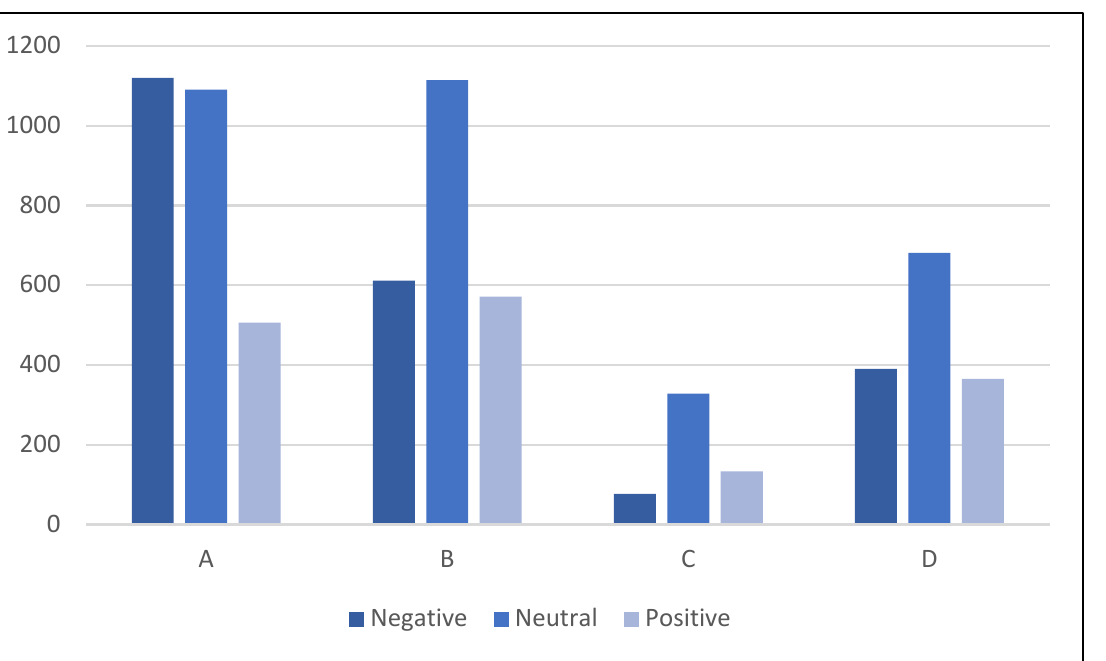
The complete body of work was tokenized, filtered with stop words eliminated, and converted to lower case functions in order to extract only individual word properties.